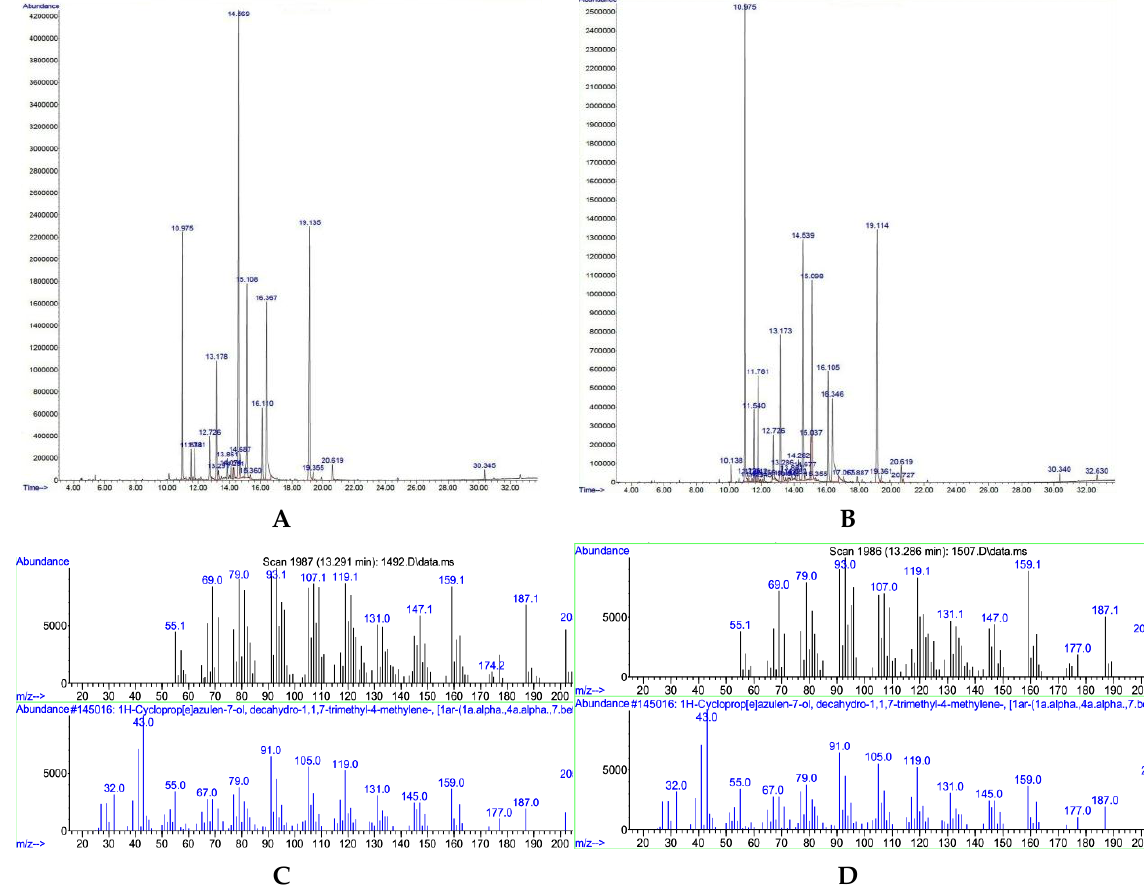
Figure 1. ( A ) A typical GC chromatogram for the Bodegold cultivar treated with 25 mg · L − 1 SA under normal conditions; ( B ) a typical GC chromatogram for the Bodegold cultivar treated with 25 mg · L − 1 SA under heat stress conditions; ( C ) a typical MS spectrum for chamazulene compound in the Bodegold cultivar treated with 25 mg · L − 1 SA under normal conditions; and ( D ) a typical MS spectrum for chamazulene compound in the Bodegold cultivar treated with 25 mg · L − 1 SA under heat stress conditions.